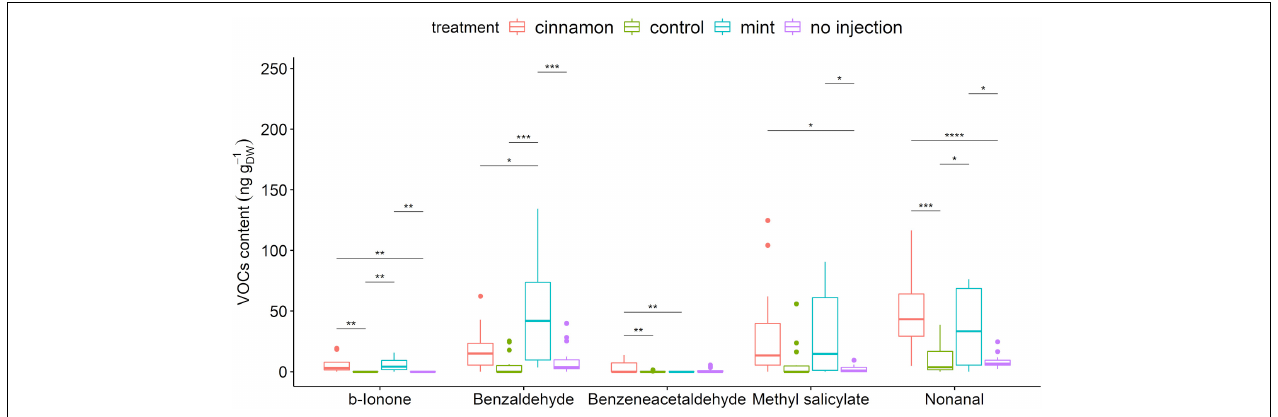
FIGURE 6 | Boxplot of a selection of Malus domestica volatile organic compounds (VOCs)content (ng g DW - 1 ) from plants injected with mint and cinnamon essential oils (EOs) and the control. The asterisk symbols above the bars indicate a significant difference between the means ( P < 0.05).